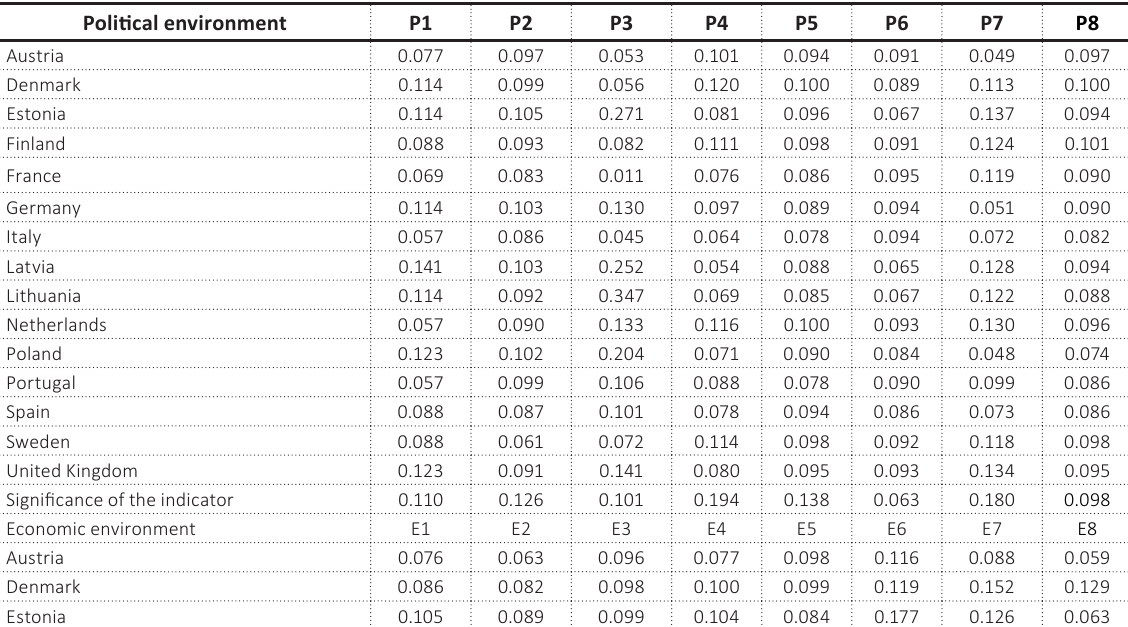
Source: Pauliukevičienė and Stankevičienė (2021).